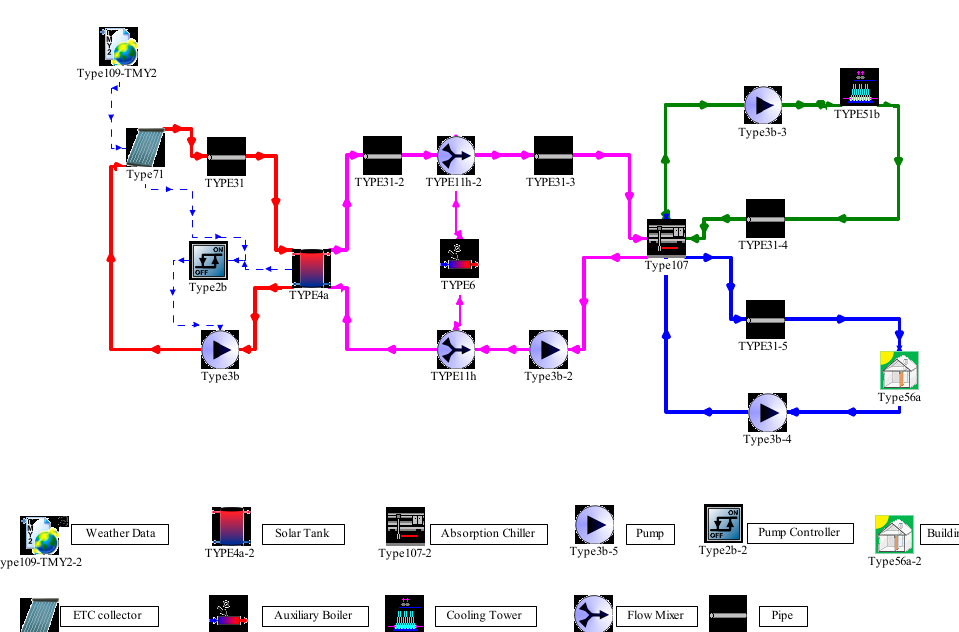
Figure 4. Contribution of the various cooling load component.